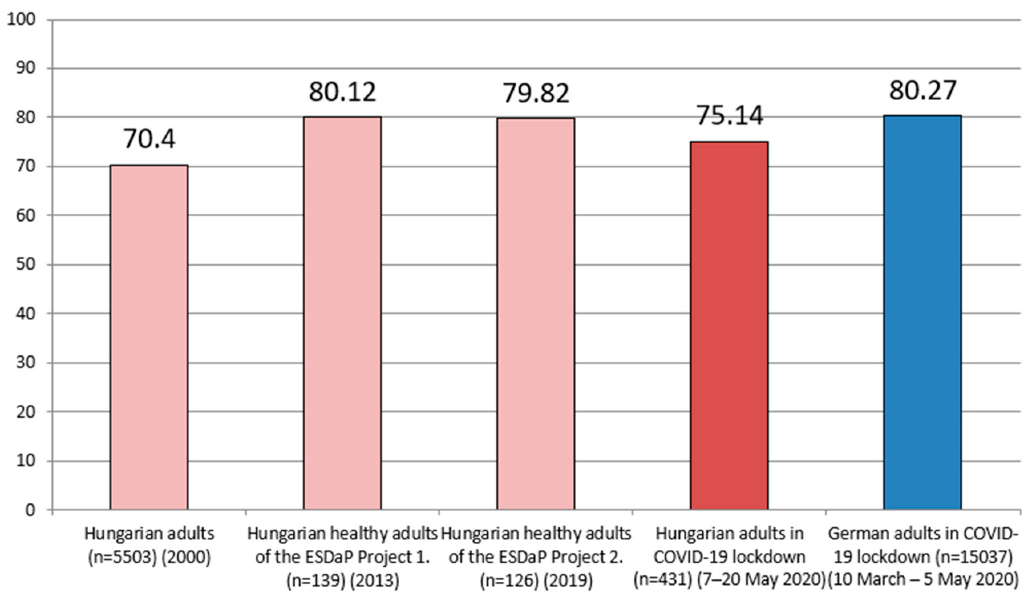
Figure 2. Health status results (measured with the EQ-VAS) of Hungarian adults without data with significant outliers ( n = 418) during coronavirus lockdown compared to previous Hungarian scores and German residents’ scores during coronavirus